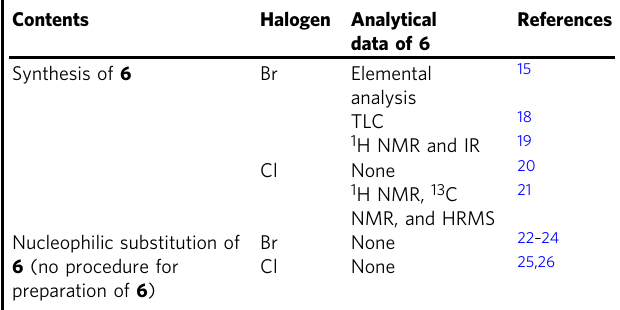
Figure 11 in Supplementary Information page S33). Our observed